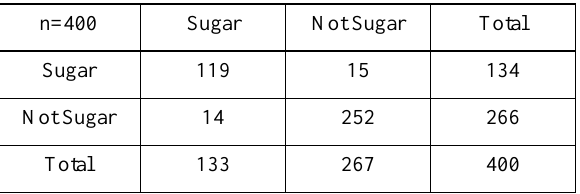
Table 5. Confusion Matrix.